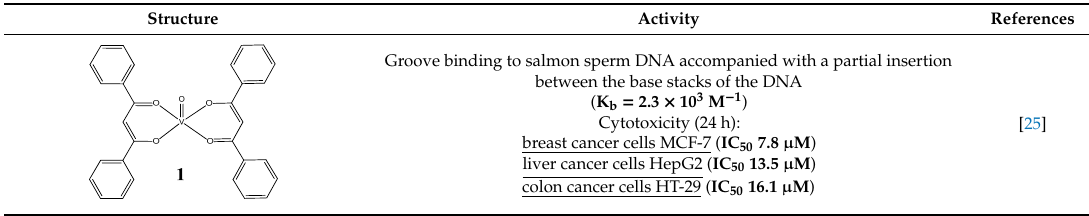
Table 1. Structures and mechanism of action DNA-binding vanadium compounds (K b -binding constant).